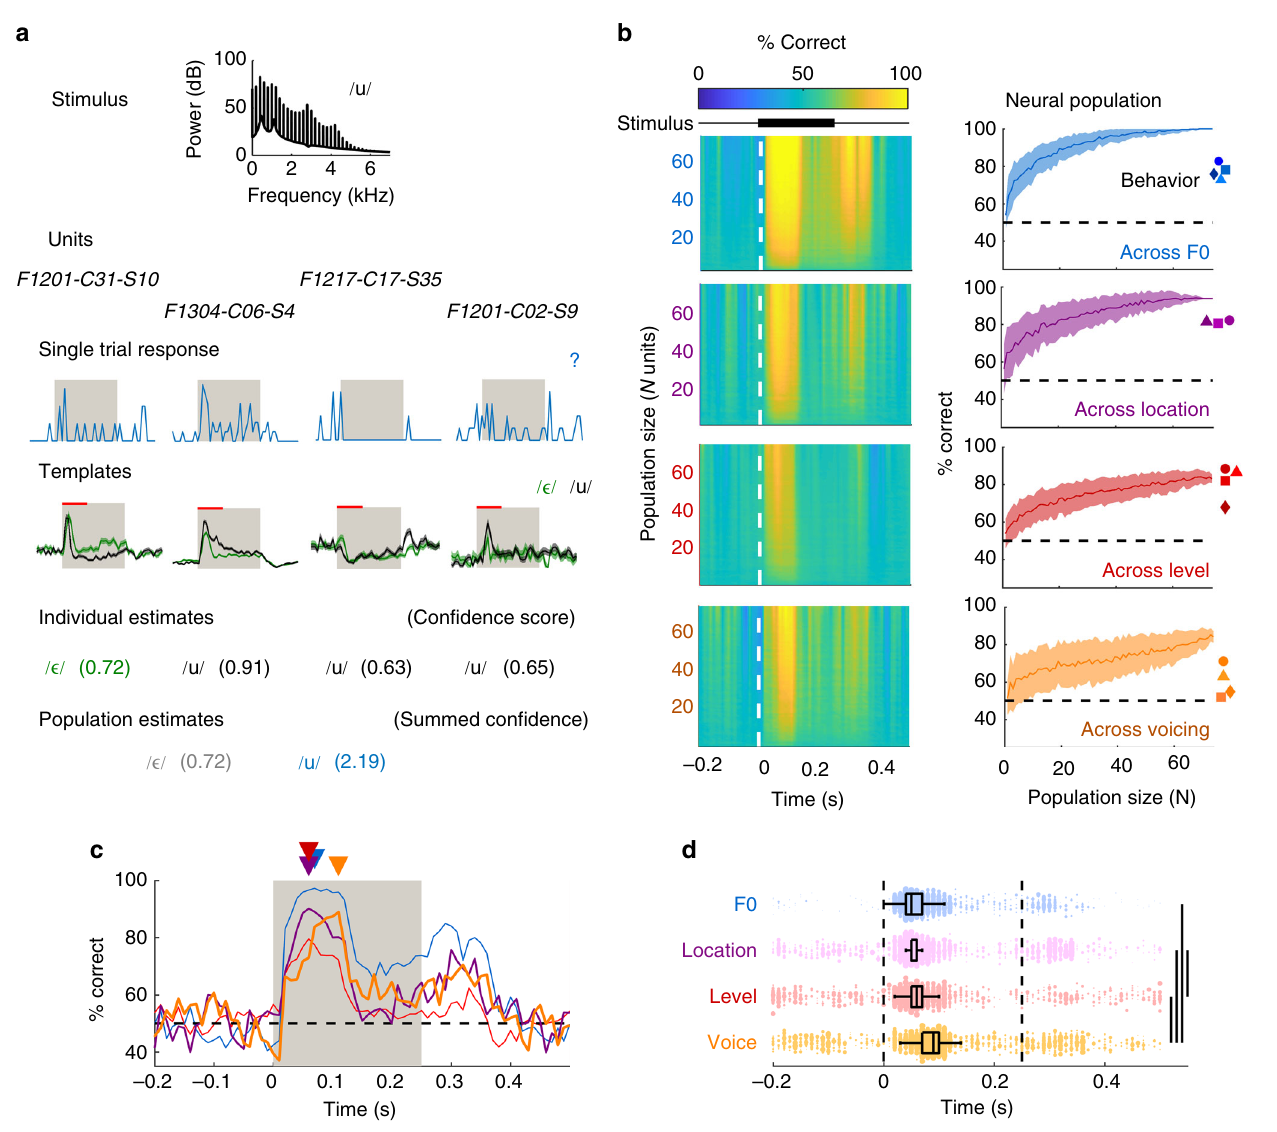
Fig. 5 Population decoding can match behavioral performance. a Schematic illustrating population decoder using four constituent units: On each trial, vowel identity (top row) was estimated independently by each unit within the population (second row) using the distance between the pattern of neural activity on that trial (third row) and templates built from responses on all other trials (fourth row). For each unit, we obtained an estimate of the stimulus feature and a weight (individual estimate and con fi dence score; fi fth row). Con fi dence weights for each vowel were summed (sixth row) to give a population estimate of each vowel ’ s likelihood, with the maximum weight giving the population estimate. Red lines above templates indicate the time window of response considered, which was consistent across units and roved in the main analysis. The decoding procedure was repeated across trials using leave- one-out cross-validation to estimate population performance. Units contributing to each population were randomly subsampled. b Performance decoding vowel identity across F0, location, level or voicing using varying populations size and neural activity measured in roving 100 ms windows. Surface plots (left) show mean performance of populations ( n = 100) sampled with different constituent units. Line plots (right) show decoding performance as a function of population size using neural activity between 0 and 100 ms after stimulus onset. Error bars show standard deviation across populations ( n = 100) with different constituents. Data points show the behavioral performance of each ferret (F1201: circles; F1203: triangles; F1217: squares; F1304: diamonds) for each orthogonal dimension. c Mean decoding performance across all population sizes reveals later decoding of vowels across voicing than other features (F0: blue; Location: purple; Level: red; Voicing: orange). Triangle markers indicate the time of peak performance for each orthogonal condition. d Comparison of best decoding performance across every population tested. Marker size indicates population size (1 – 74 units) with marker position showing the time at which each population decoded vowels best. Boxplots show median, interquartile range (box) and 99.3% intervals (whiskers). Lines show signi fi cant comparisons across dimensions (permutation test, p <